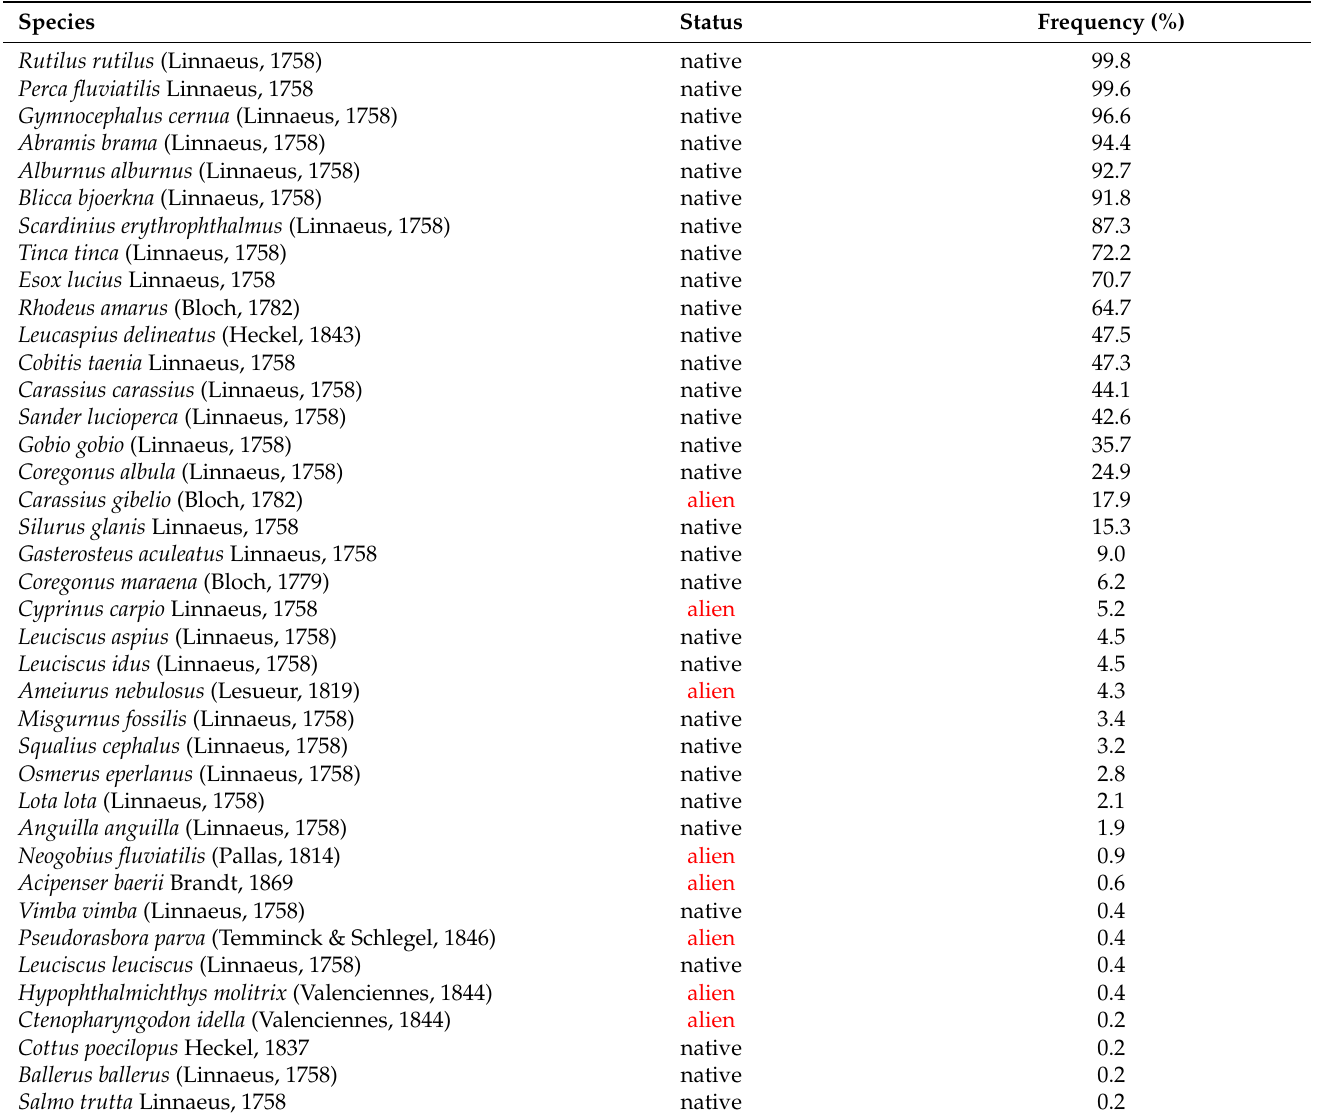
Table 1. List of caught fish species, their status, and frequency in 535 Polish